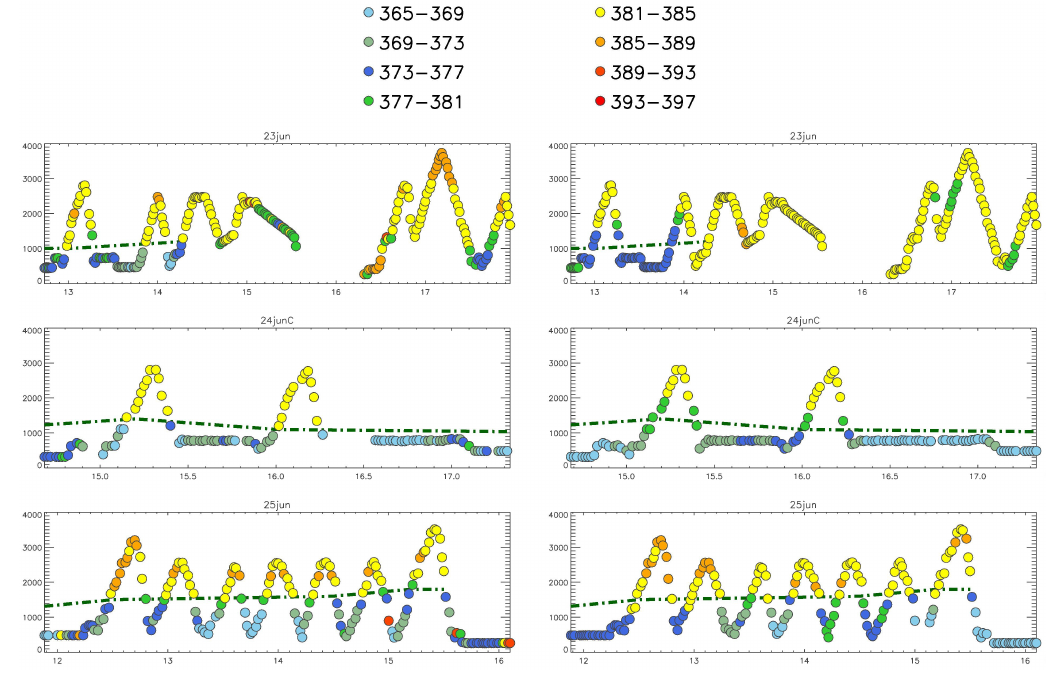
Fig. 4. Same figure for June 23, 24 and 25 flights